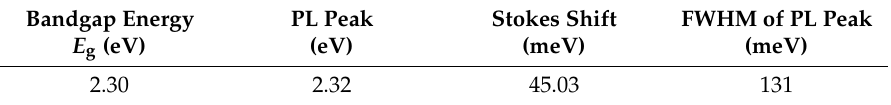
Figure 3. ( a ) Absorption coe ffi cient spectra and ( b ) PL spectra of the CsPbBr 3 / PMMA thin disk. Table 2. Absorption and PL parameters of the CsPbBr 3 / PMMA thin disk.